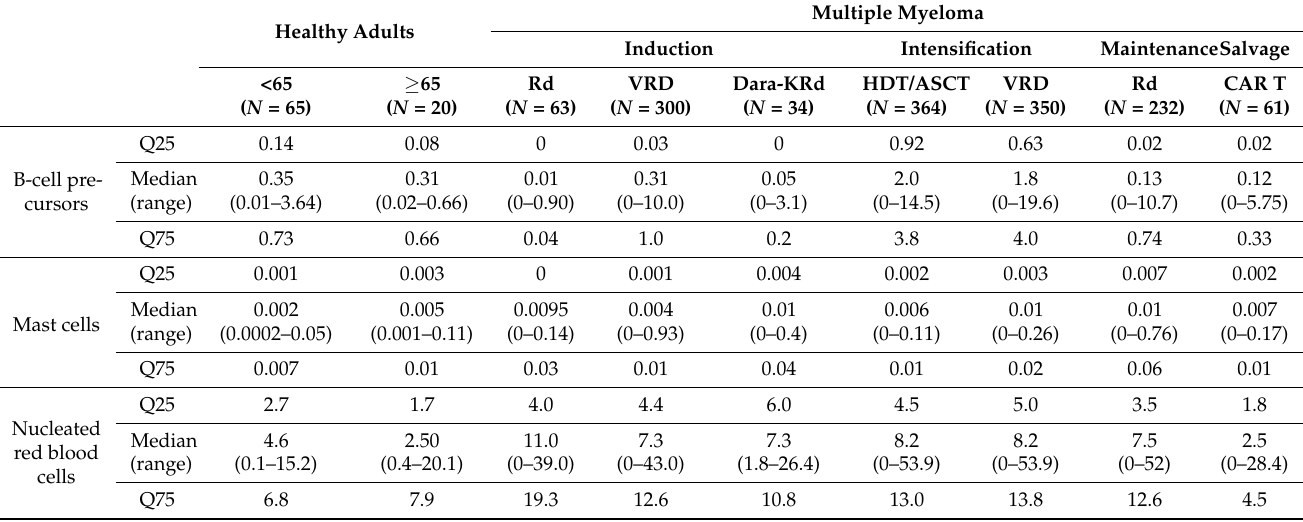
Table 1. Median (range) and quartile percentages of B-cell precursors, mast cells and nucleated red blood cells in bone marrow aspirates of healthy adults grouped according to age (below or above 65 years) and patients with multiple myeloma. The latter are grouped according to treatment: induction with lenalidomide and low-dose dexamethasone (Rd) with or without clarithromycin, bortezomib, lenalidomide and dexamethasone (VRD) and daratumumab, carfilzomib, lenalidomide and dexamethasone (Dara-KRd); intensification with high-dose chemotherapy followed by autologous stem cell transplantation (HDT/ASCT) or consolidation with VRD; maintenance therapy with Rd plus/minus ixazomib and salvage therapy with anti-BCMA CAR T cells.